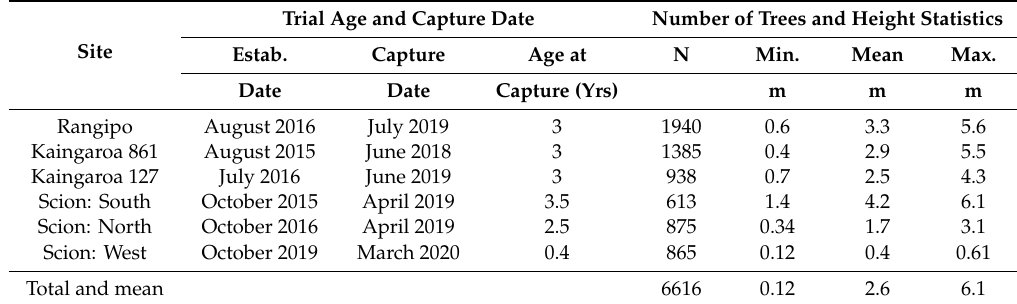
Table 1. Description of the establishment date, point cloud capture date and age at the capture date. The number of trees (N) measured at each site and the mean and range of measured heights are also shown.